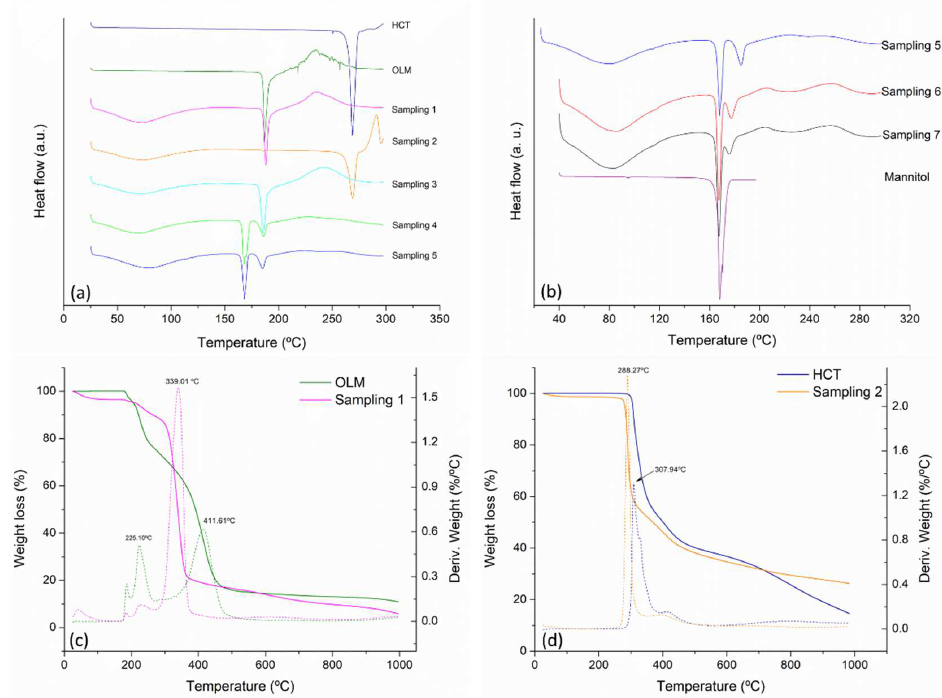
Figure 5. DSC curves of F 1 ( a ) pure OLM, HCT, and sampling from 1 to 5, ( b ) sampling from 5 to 7 and mannitol, ( c ) thermograms of OLM and sampling 1 and ( d ) thermograms of HCT and sampling 2. (Dotted lines represent the derivative of % weight loss as a function of temperature).